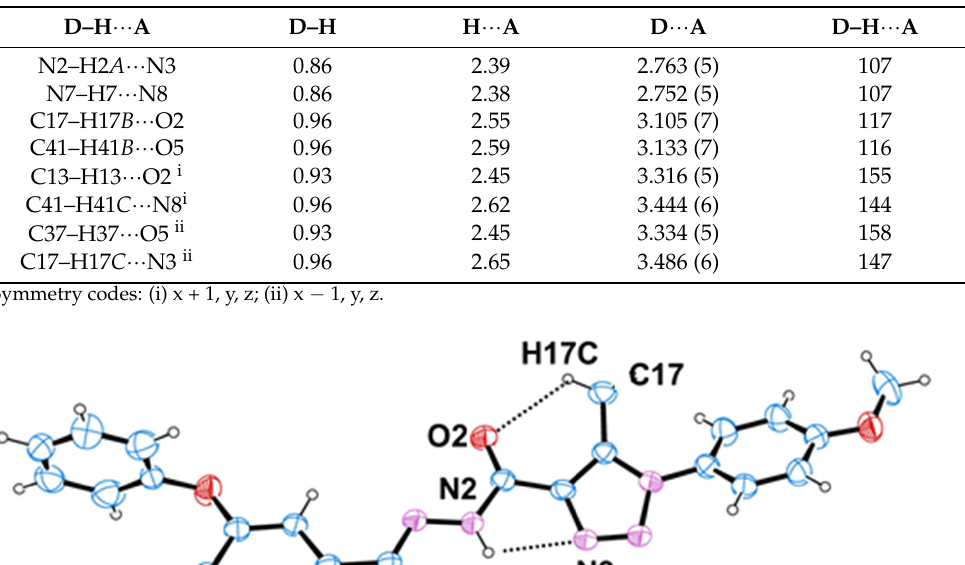
Table 1. Hydrogen bond geometry (Å, ◦ ) of compound 2 .